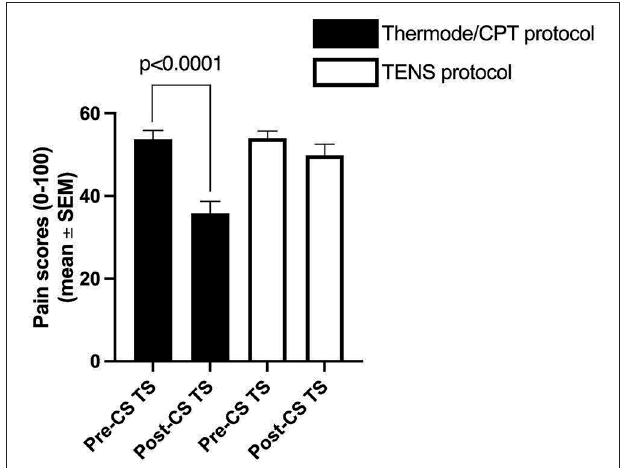
FIGURE 2 | Average pain levels elicited by the thermode/CPT protocol and TENS protocol throughout the pre- and post-CS TS. CPT, cold pressor test; TENS, transcutaneous electrical nerve stimulation; CS, conditioning stimulus; TS, test stimulus.